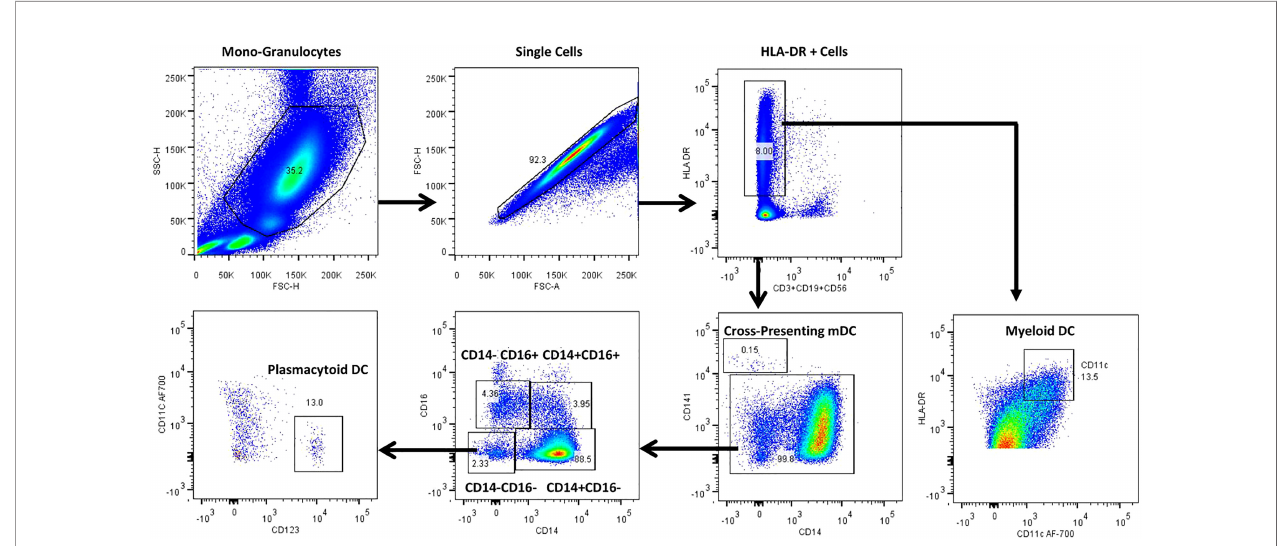
FIGURE 4 | Representative gating strategy for dendritic cells and their subsets. Monocyte and granulocyte population were gated on whole blood cell plot excluding lymphocytes by Forward (FSC-A) and Side scatter (SSC-A) based on its size and granularity. Singlets were discriminated from doublets by FSC (A) vs FSC (H). Lineage negative cells were identi fi ed with the help of dump gate by excluding T cells, B cells and NK cells using CD3, CD19 and CD56 markers. HLA-DR+ were gated to obtain HLA-DR + CD11c + myeloid DCs (mDC), cross-presenting HLA-DR + CD14 - CD141 + myeloid DCs and HLA-DR + CD14 - CD16 - CD11c - CD123 + plasmacytoid DCs (pDC).